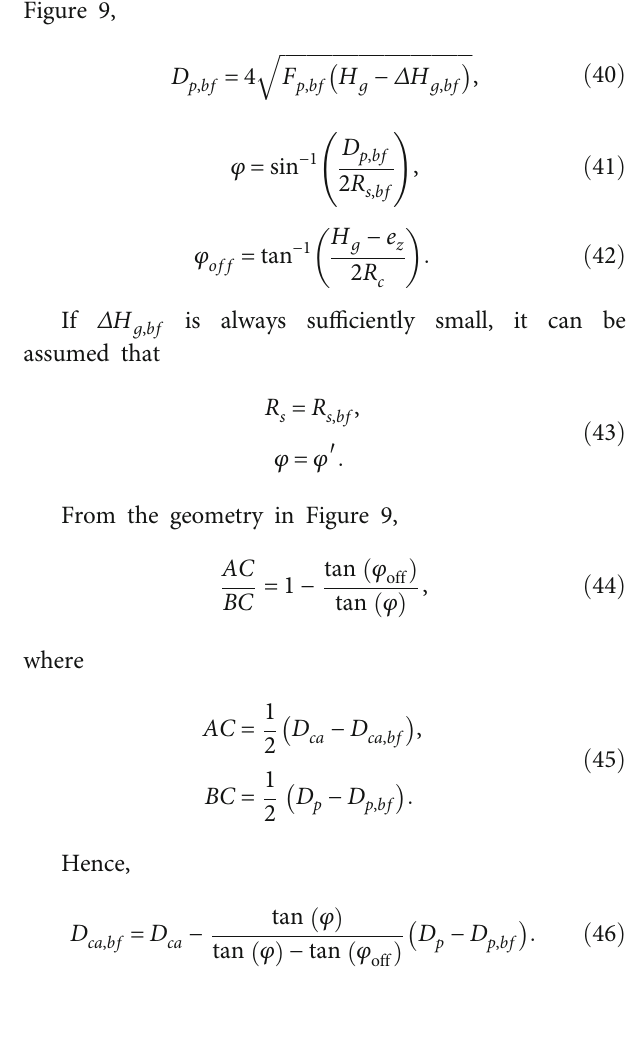
and Δ H are the parent p , bf g , bf -plane. From z g g